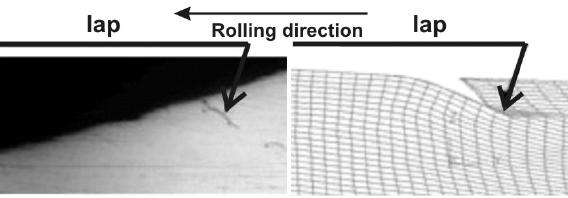
Figure 6. The generation of lap during both simulation ( T 0 D 1423 K, T " D 1373 K, " D 30